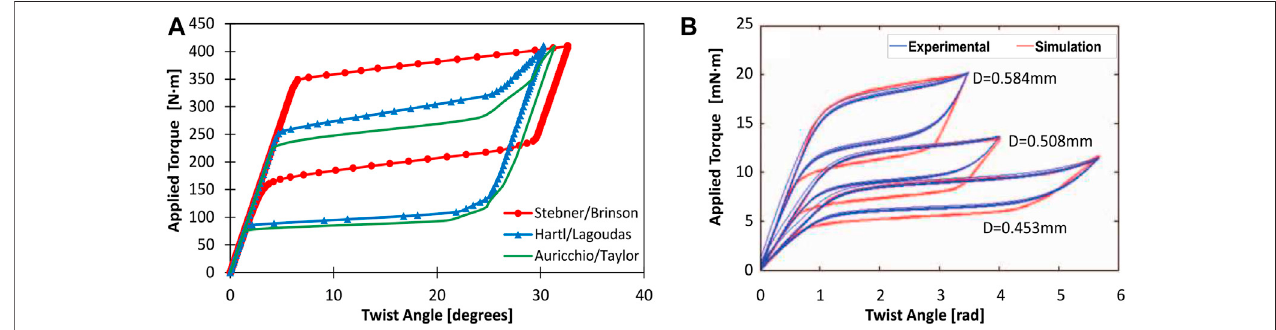
FIGURE10 | An exampleof simulation results with 3D FEM frameworksfor pure torsional SMA elements: (A) Torsional PEbehaviorof acentimetre-size SMA tube form actuator for different models (Abaqus) (Zhu et al., 2013). (B) Torsional PE behavior of millimetre-size SMA wire form actuators for different diameters (Abaqus), the fi gure is reproduced from Chapman et al.